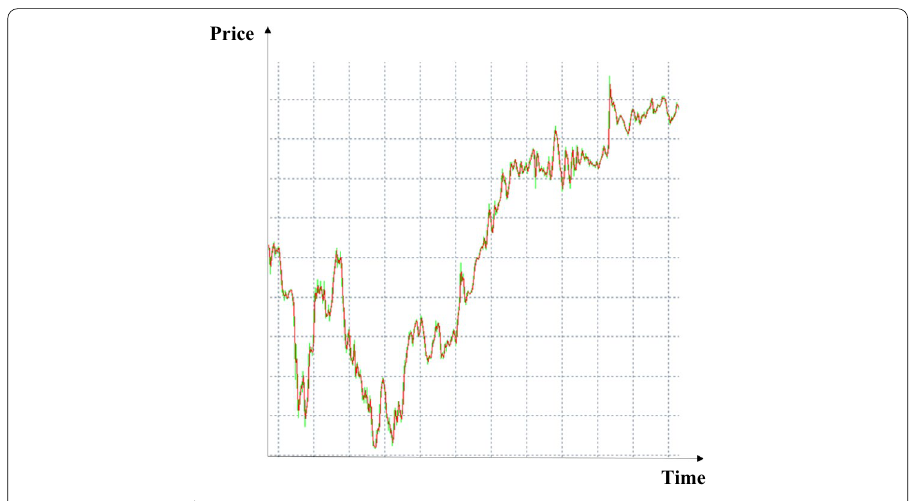
Fig. 6 GA-BP network